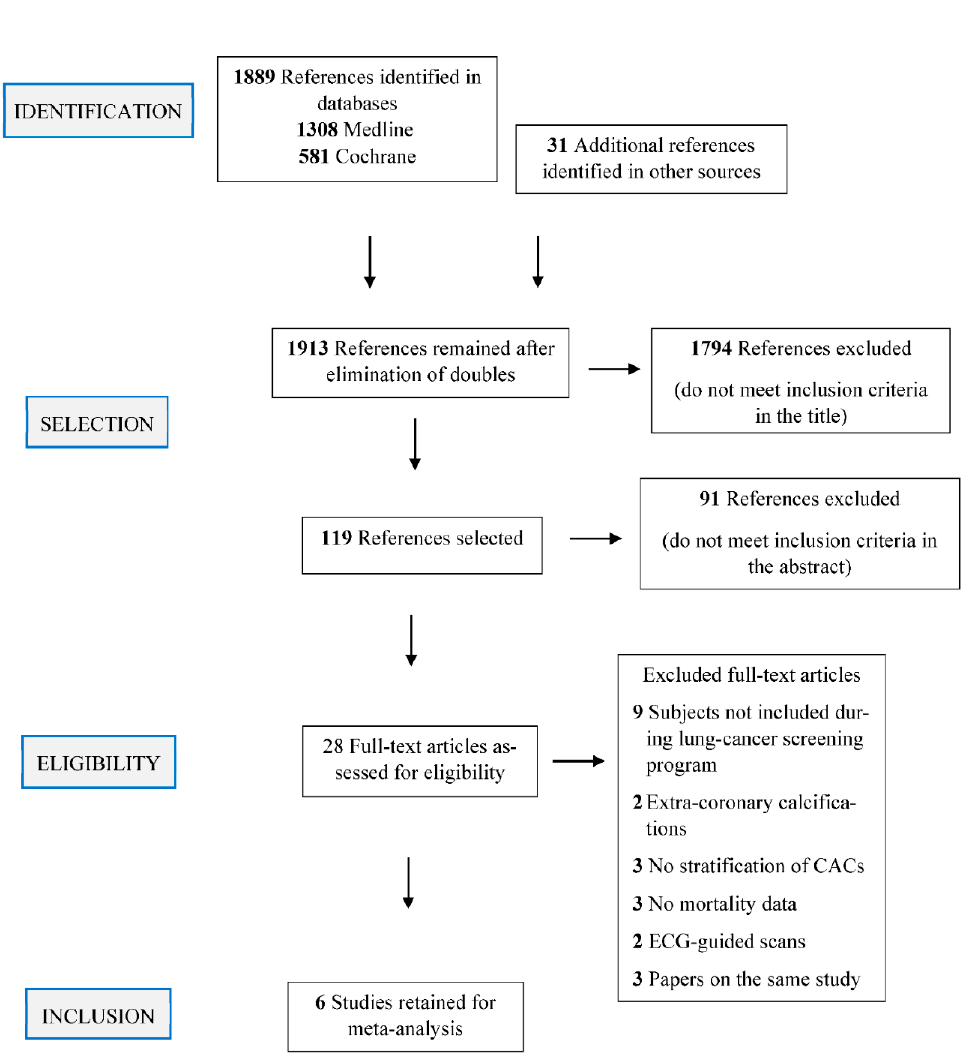
Figure 1. Flow chart for article selection.